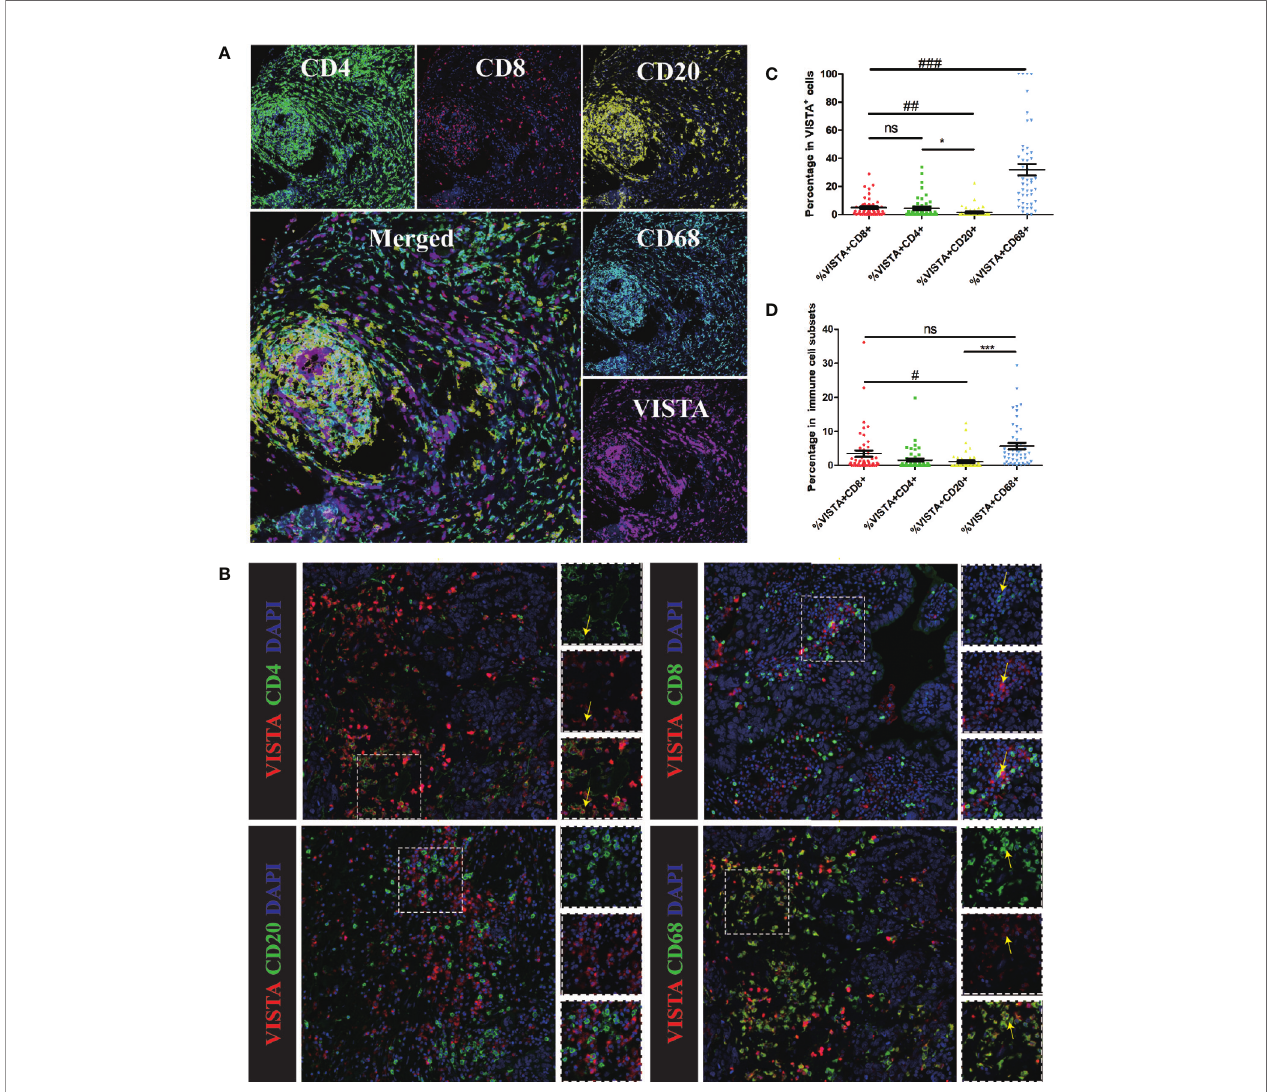
FIGURE 4 | Multiplex immuno fl uorescence for VISTA and selected tumor-in fi ltrating immune cell markers in human breast cancer tissue. Markers of tumor-in fi ltrating immune cells: CD68 (macrophages), CD4 (T cells), CD8 (cytotoxic T cells) and CD20 (B cells). (A) Representative images of biomarkers in human breast cancer tissue. CD4 staining is shown in green; CD8 staining is shown in red; CD20 staining is shown in yellow; CD68 staining is shown in cyan; VISTA staining is shown in magenta; and DAPI staining is shown in blue. 400×. (B) Co-localization of VISTA with selected tumor-in fi ltrating immune cell markers in breast cancer detected by immuno fl uorescence. CD4, CD8, CD20, and CD68 staining is shown in green; VISTA staining is shown in red; and DAPI staining is shown in blue. Areas of co- localization are indicated with yellow arrows. 400×. (C) . Summary plot of the proportion of each subpopulation of cells among double-positive cells. Each dot represents data from an individual patient. P-values were obtained by an unpaired T-test. * p < 0.05; ## p < 0.01; ### p < 0.001. (D) Summary plot of the proportion of double-positive cells in each subpopulation of cells. Each dot represents data from an individual patient. P-values were obtained by an unpaired T-test. # p < 0.05; *** p < 0.001. NS, no signi fi